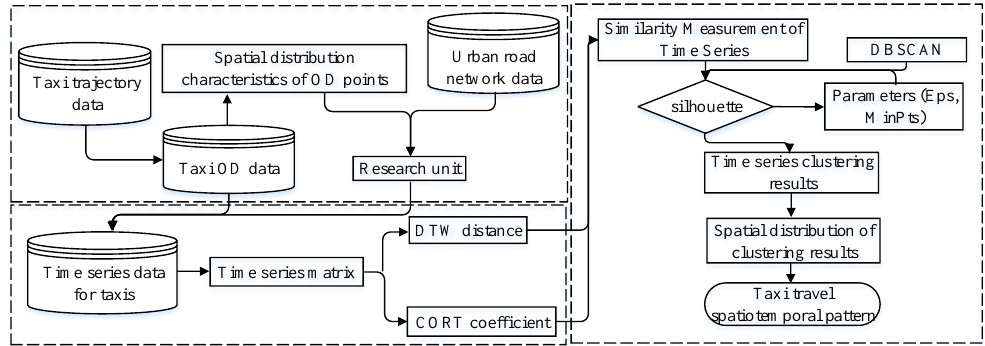
Figure 1. Overview of the procedure for collective human mobility spatiotemporal pattern recognition.